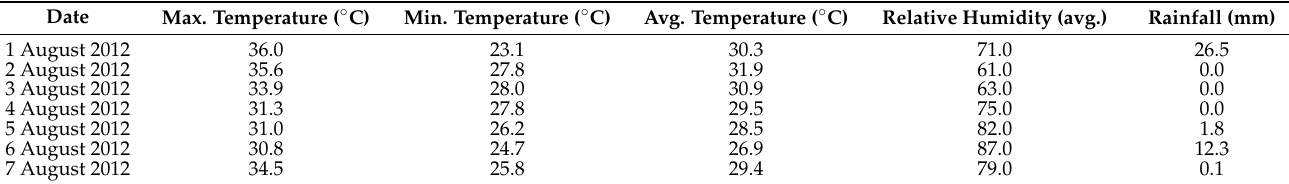
Table 2. Data of meteorological factors from 1 August to 7 August 2012 (Area